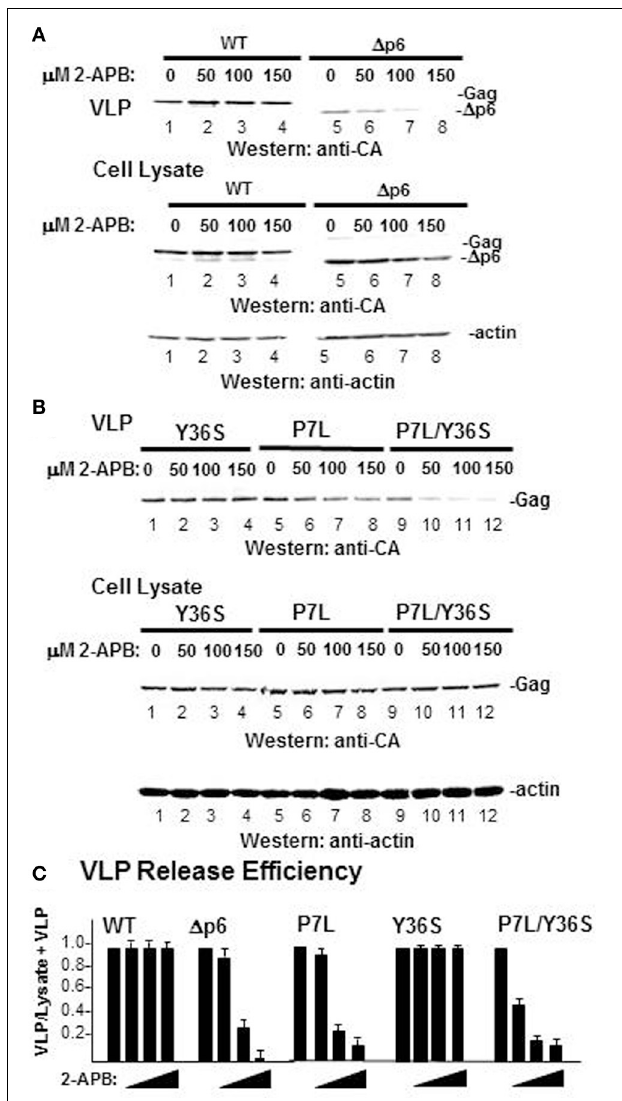
FIGURE 10 | L domain-dependent resistance to 2-APB-mediated inhibition of SOCE. COS-1 cells were transfected with DNA encoding: (A) WT Gag (WT, lanes 1–4 ) or a Gag mutant missing the entire C-terminal p6 region ( (cid:2) p6, lanes 5–8 ); (B) Gag with a Tyr36 to Ser substitution in L Domain-2 in p6 (Y36S, lanes 1–4 ); Gag with Pro7 to Leu substitution in L Domain-1 (P7L, lanes 5–8 ); or Gag with both substitutions (P7L/Y36S, lanes 9–12 ). At 24h post-transfection, the tissue culture media was replaced with treatment media containing DMSO or increasing concentrations of 2-APB. After 24h, tissue culture media and cells were harvested for Western analysis of Gag VLP ( top ), cell-associated Gag ( middle ), and actin ( bottom ). (C) VLP release efficiency. To facilitate sample comparison, more cells were used for samples containing the P7L and P7L/Y36S